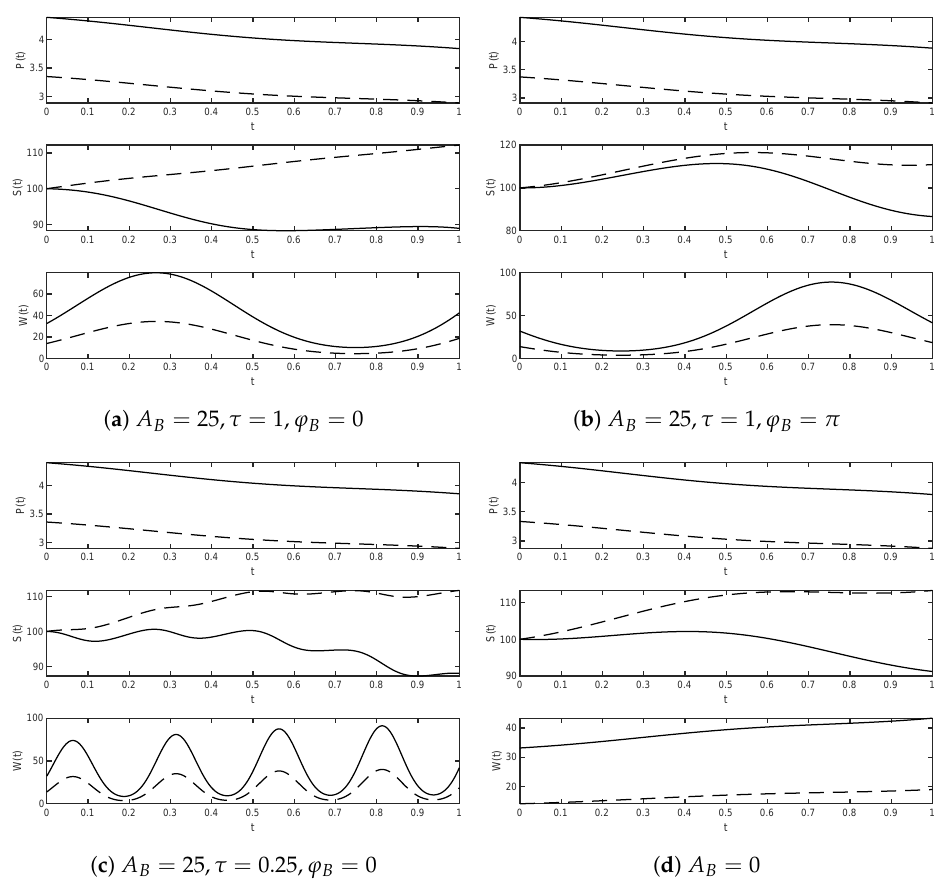
Figure 1. Different scenarios for the dynamics of p ∗ ( t ) , S ∗ ( t ) and W ∗ ( t ) . The continuous lines refer to the case with a linear price scheme, while the dashed lines refer to the case with a convex tariff scheme ( α = 2).